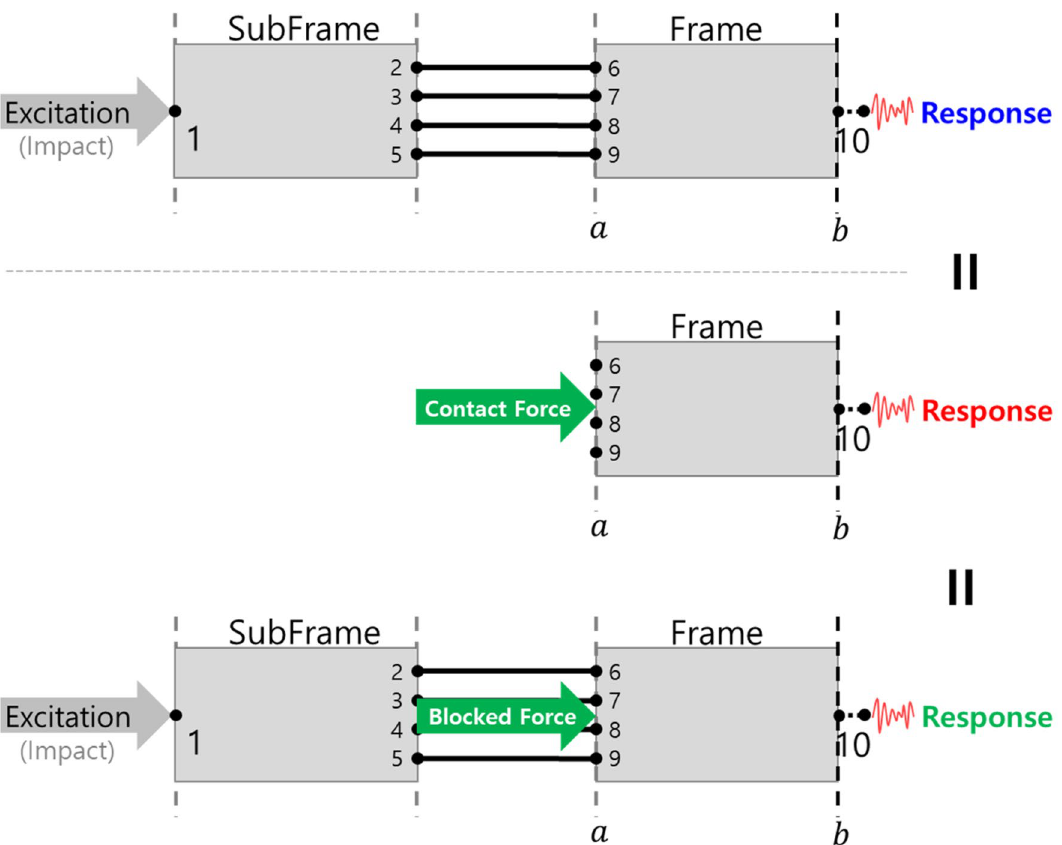
Figure 9. Response prediction using contact force and blocked